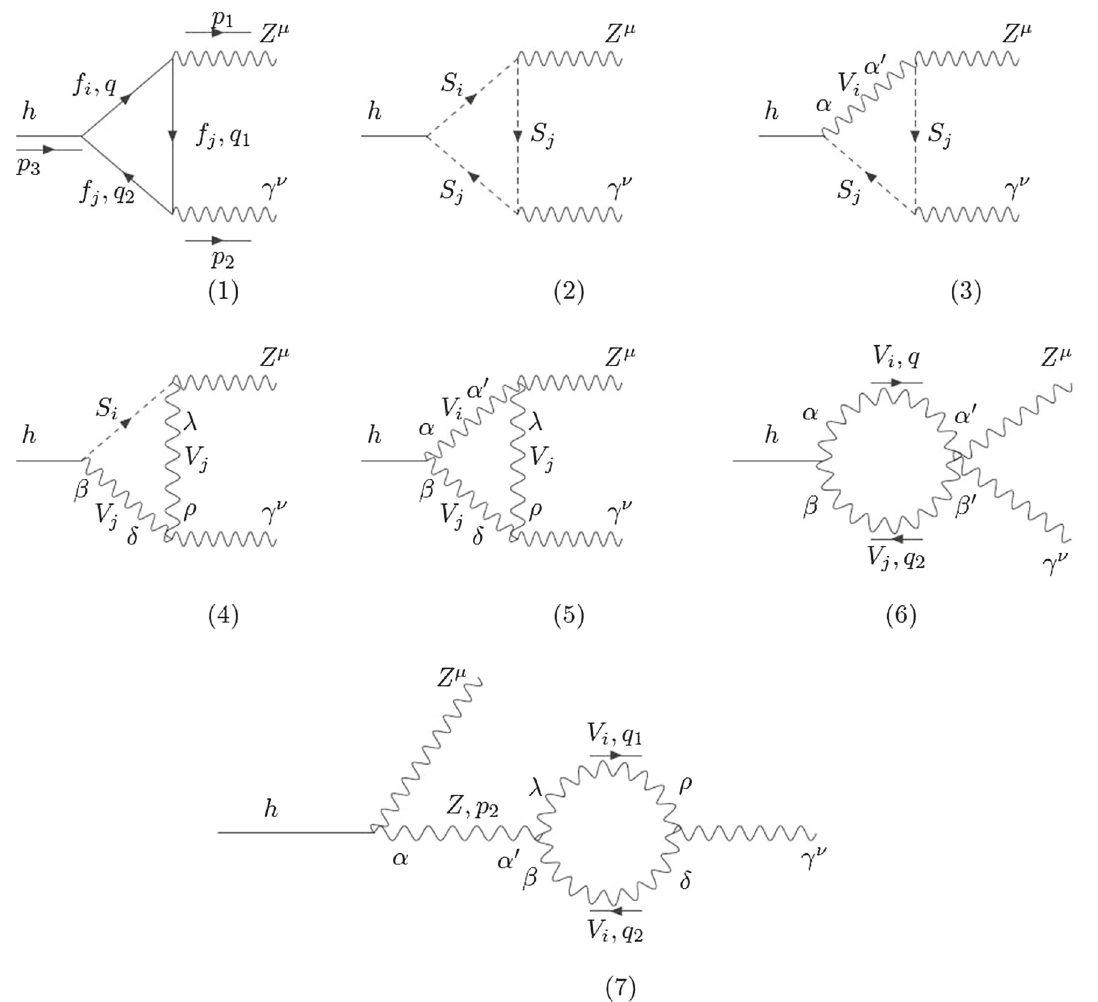
Fig. 1 One-loop diagrams contributing to the decay h → Z γ , where f i , j , S i , j and V i , j are fermions, Higgs, and gauge bosons, respectively M μν = 0, resulting in F = 0 and p ν 11 2